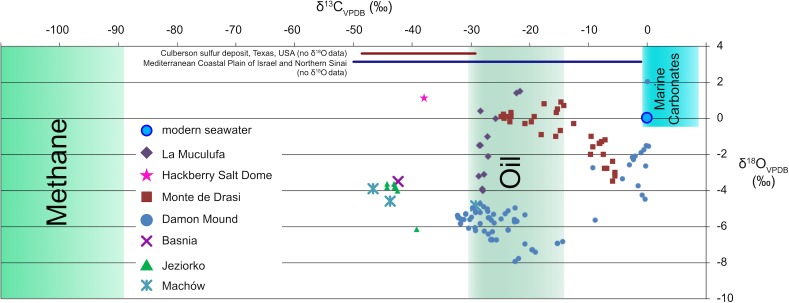
Carbon isotopes systematics in epigenetic sulfur deposits. Compilation of carbon isotope data from carbonates from epigenetic native sulfur deposits. Thermogenic or biogenic methane is isotopically very light and may have contributed to the formation of carbonates at various sites, such as the south-eastern Mediterranean Coastal Plain of Israel and Northern Sinai (Nissenbaum, 1984), the Hackberry salt dome, Louisiana, United States (McManus and Hanor, 1993); the Carpathian Foredeep, Poland (Parafiniuk et al., 1994; Böttcher and Parafiniuk, 1998), Sicily, Italy (Ziegenbalg et al., 2012), and within stratiform native sulfur deposits in the Castile anhydrite in the northwestern and west-central Delaware Basin, United States (Kirkland, 2014). The carbon isotope composition of carbonates from Damon Mound (this study) fall almost entirely into the range between oil-derived carbon and carbonate from seawater, but a contribution from methane cannot be excluded.